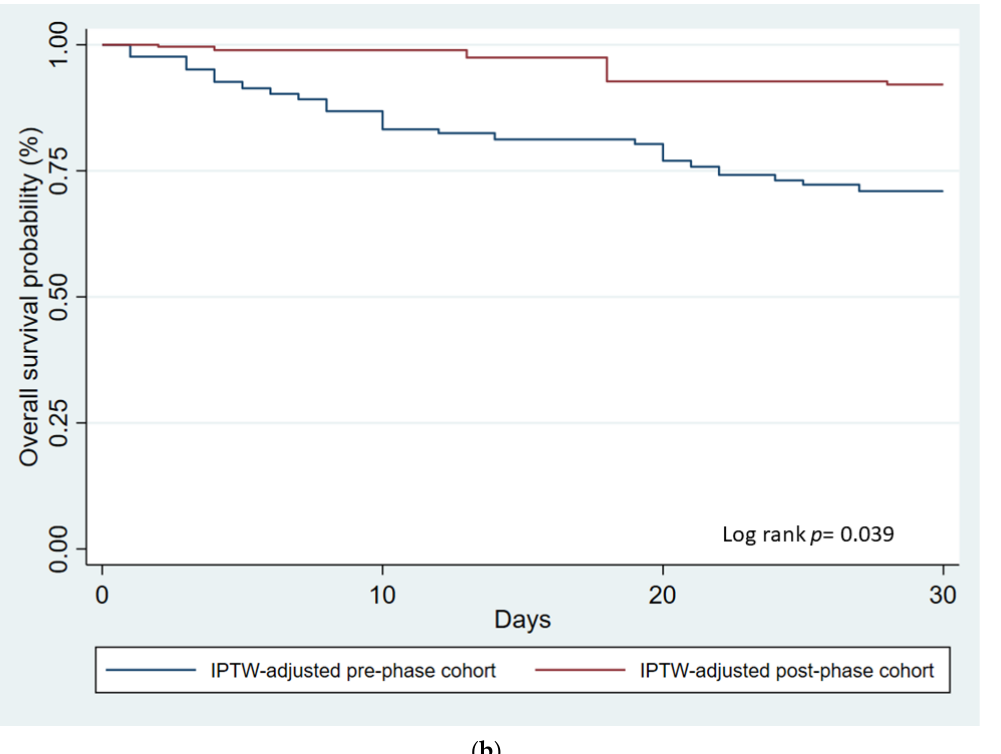
Figure 2. Kaplan-Meier survival curves of survival probability according to phase of enrolment in “real life” cohort (panel ( a )) and in the and IPTW-adjusted pseudo-population (panel ( b )). Legend: overall survival probability of patients enrolled in pre-phase (blue line) and post-phase (red line). Overall survival probability of patients enrolled in the IPTW-adjusted pre-phase population (blue line) and IPTW-adjusted post-phase population (red line).